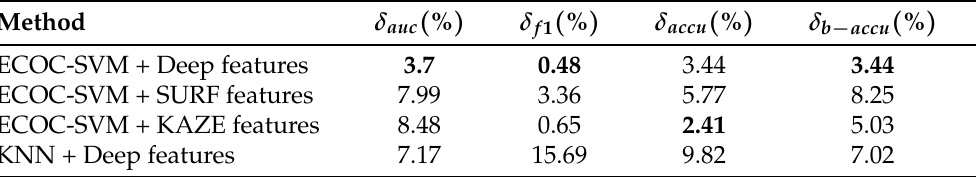
Table 4. The differences in AUC, F1-Score, accuracy, and the balanced accuracy as a percentage of the top four methods on the training data set and the test data set. The differences of AUC, F1-Score, accuracy, and the balanced accuracy are respectively denoted by δ auc , δ f 1 , δ accu , and δ b − accu